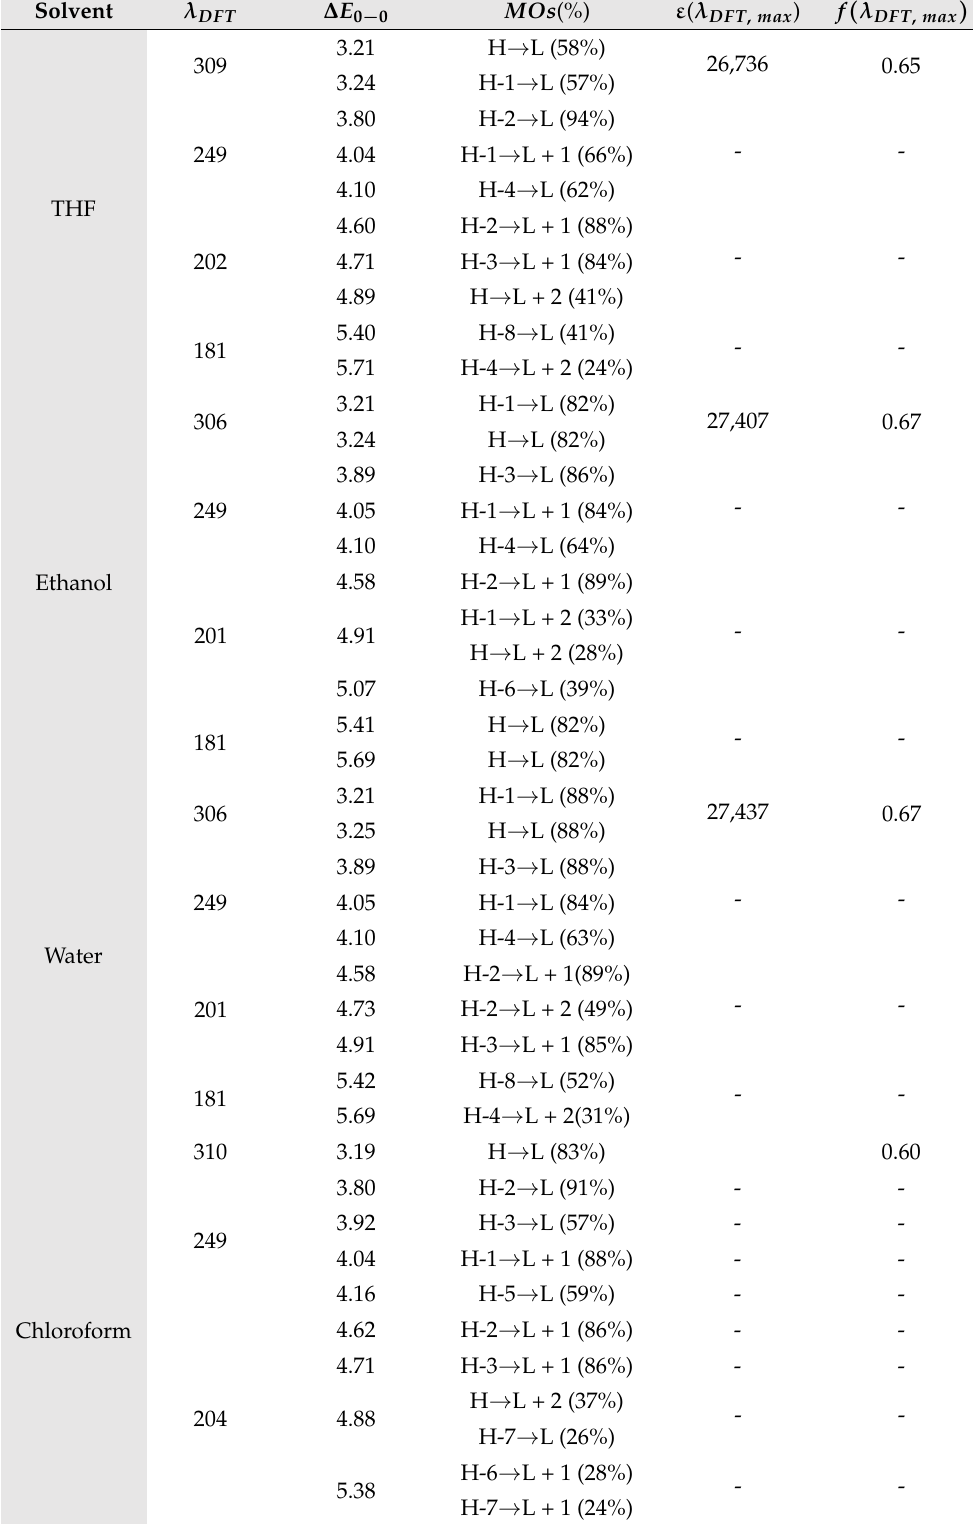
Table 4. Computed optical characteristics (wavelength ( λ DFT , nm); lowest-energy dipole-allowed excited states ( ∆ E 0 − 0 , eV); the MOs transitions (major contributions,%); molar absorption coefficient ( ε ( λ DFT , max , L · mol − 1 · cm − 1 )); and the oscillator strength of the maximum wavelength at TD-DFT B3LYP/6-31+G(d) as a function of several